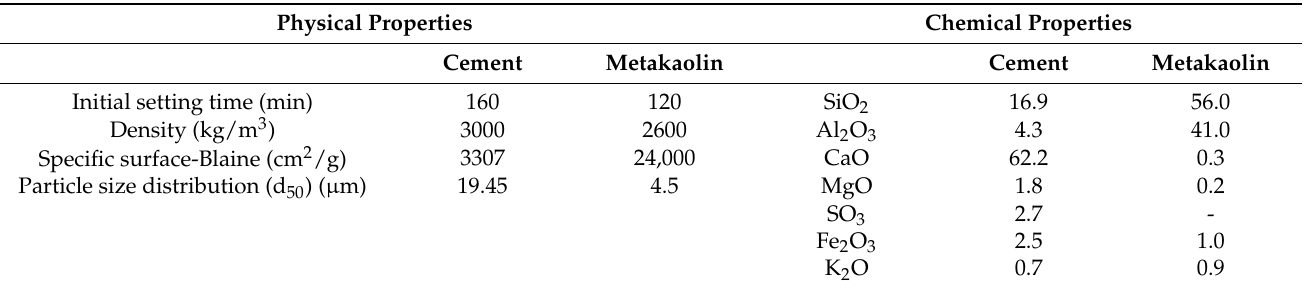
Table 1. Physical and chemical properties (% by mass) of cement and